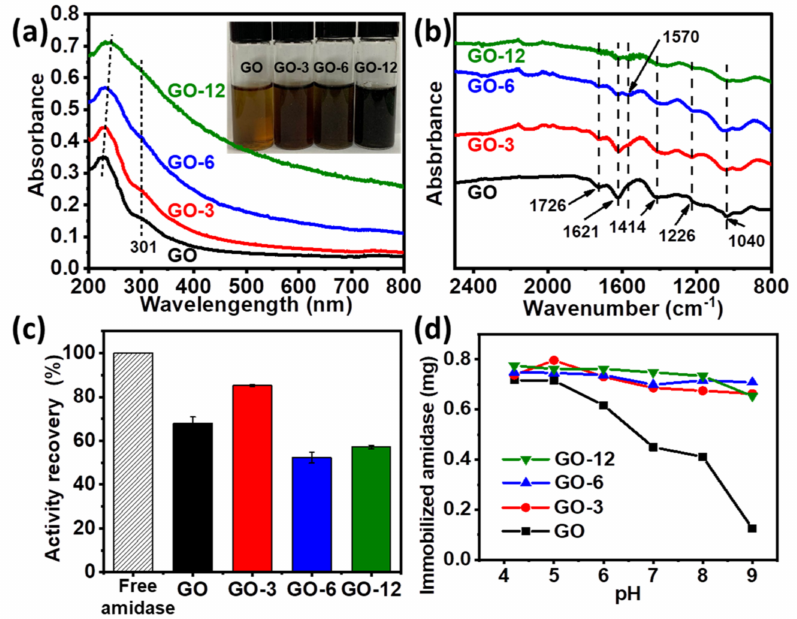
Figure 2. ( a , b ) UV-vis spectra ( a ), photograph (inset in ( a )) and FT-IR spectrums ( b ) of GO, GO-3, GO-6 and GO-12; ( c ) relative activity of free and immobilized amidase; ( d ) effect of pH on the amidase loadings on GO, GO-3, GO-6 and